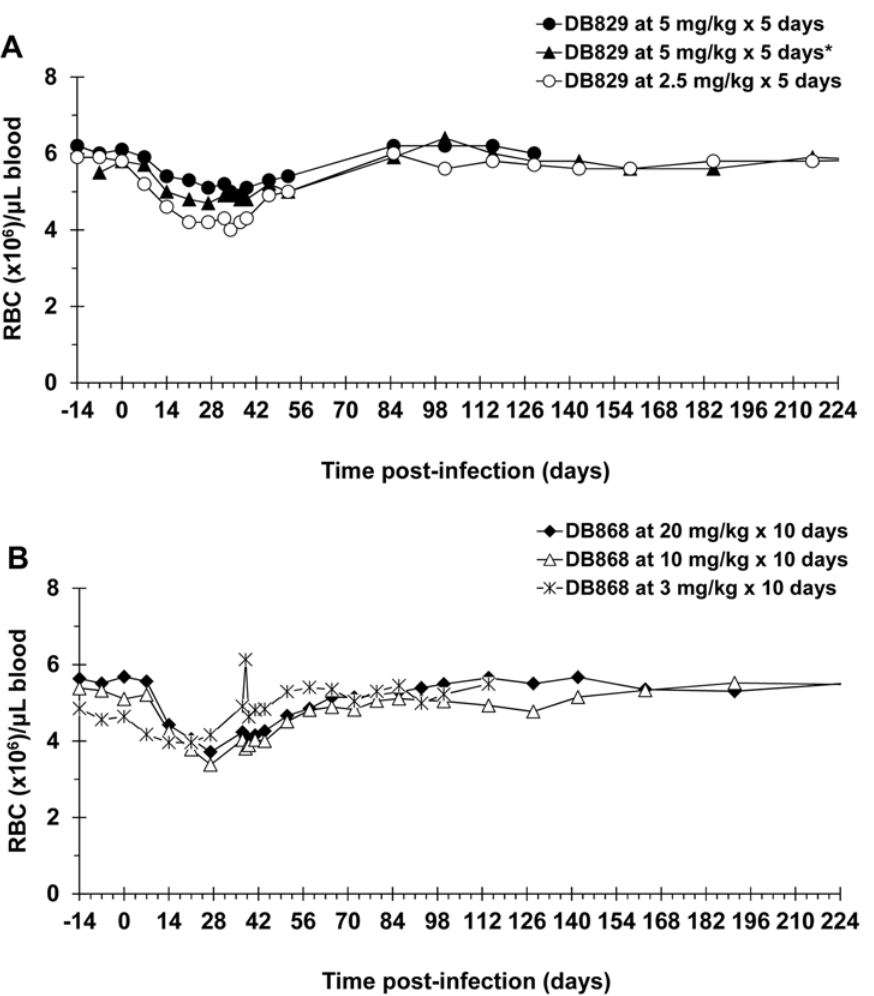
HAT, treated with ( A ) DB829 or ( B ) DB868. DB829 was administered intramuscularly for either 5 consecutive days (28 – 32 days post-infection) or 5 alternate ( * ) days (28, 30, 32, 34 and 36 days post-infection). DB868 was administered orally for 10 consecutive days (28 – 37 days post-infection). Symbols represent means ( A ; n = 2) or means and standard error of the mean ( B ; n =